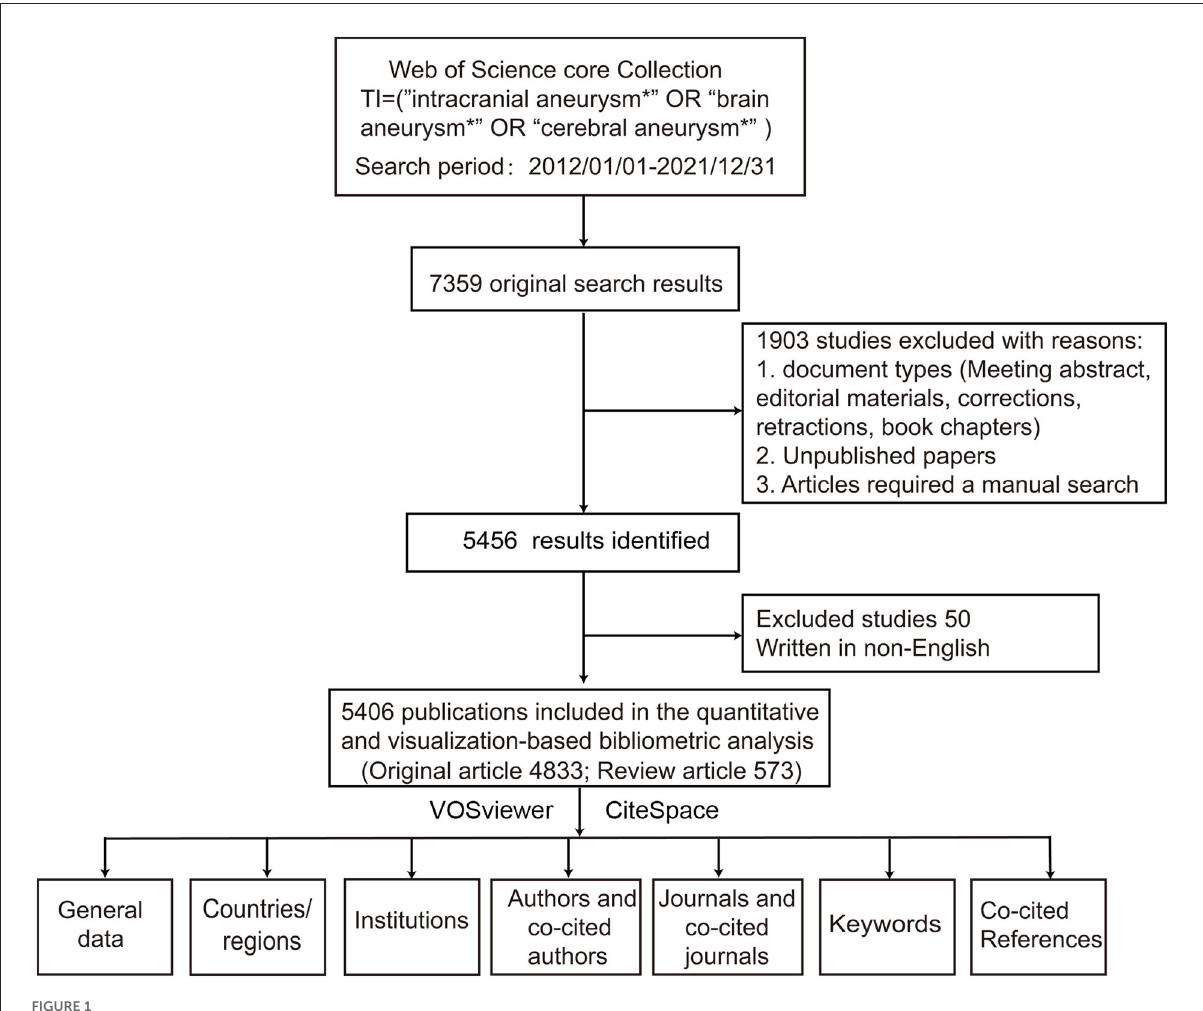
FIGURE1 A flowchart of data screening and bibliometric